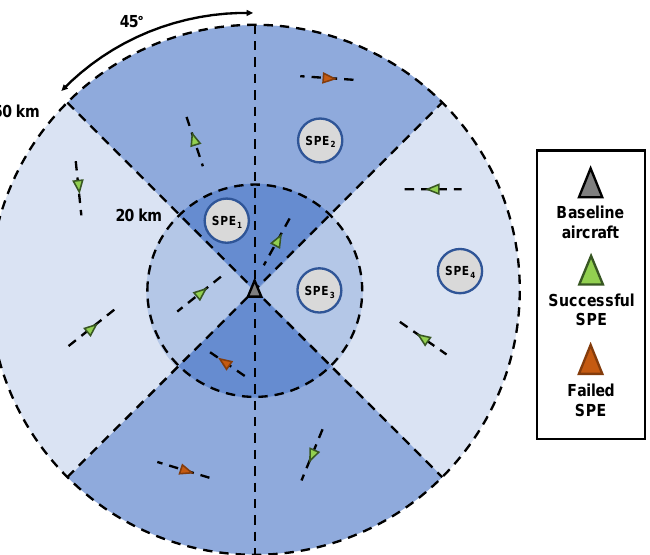
Figure 2. Schematic drawing of SPE criteria used to deduce plume overlap cases and compare the relative importance of plume intersection events.